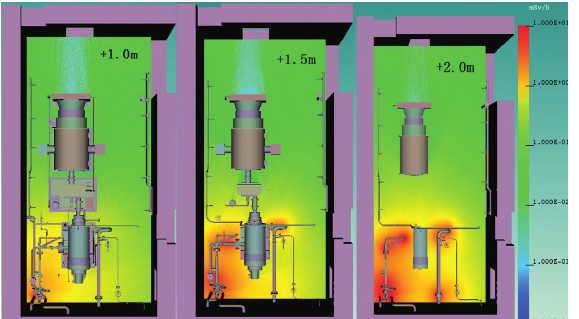
Figure 2: Theoretical 3D radiation field of the typical radioactive compartment.